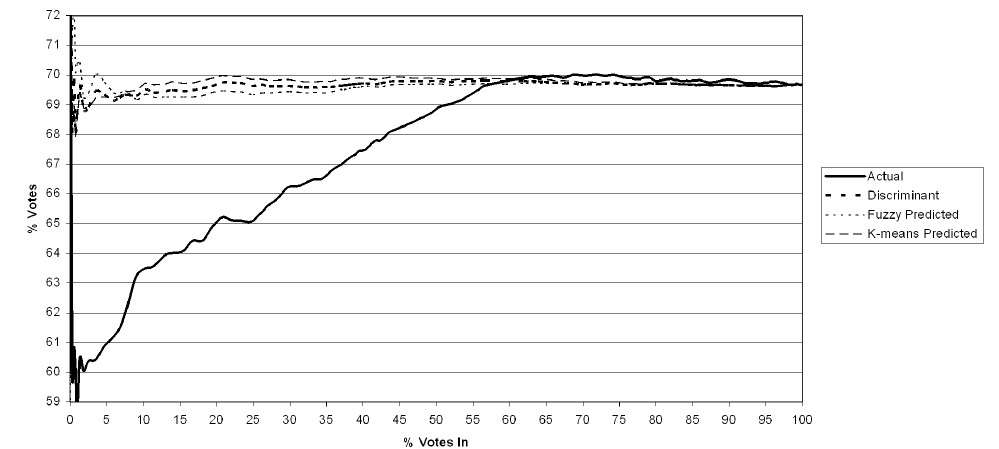
Figure 1: ANC results for the national elections in 2004 and their predictions as a function of the number of votes